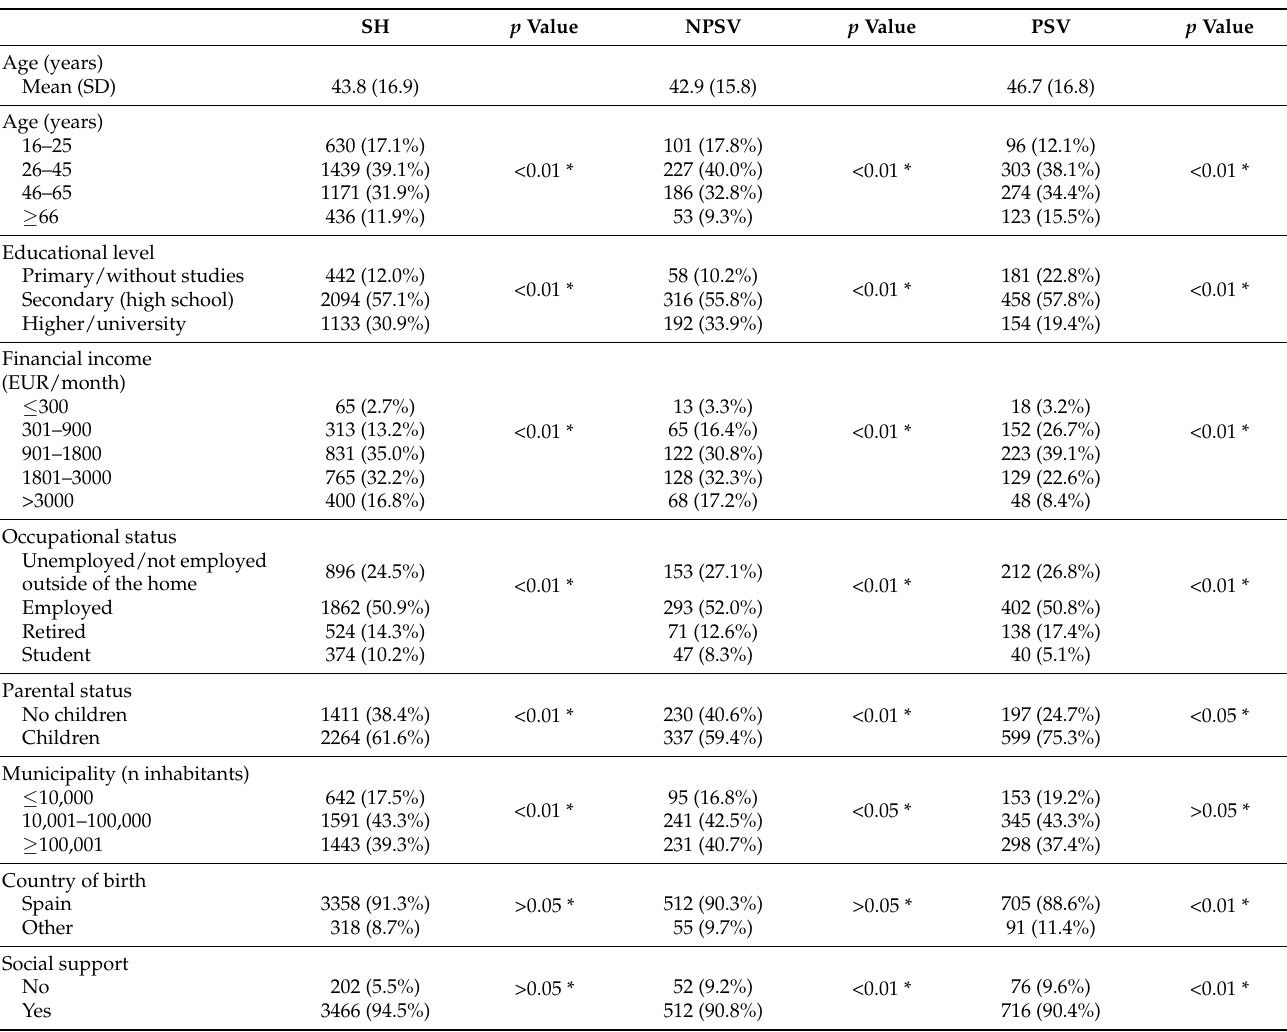
Table 2. Sociodemographic characteristics of women who have suffered different forms of sexual